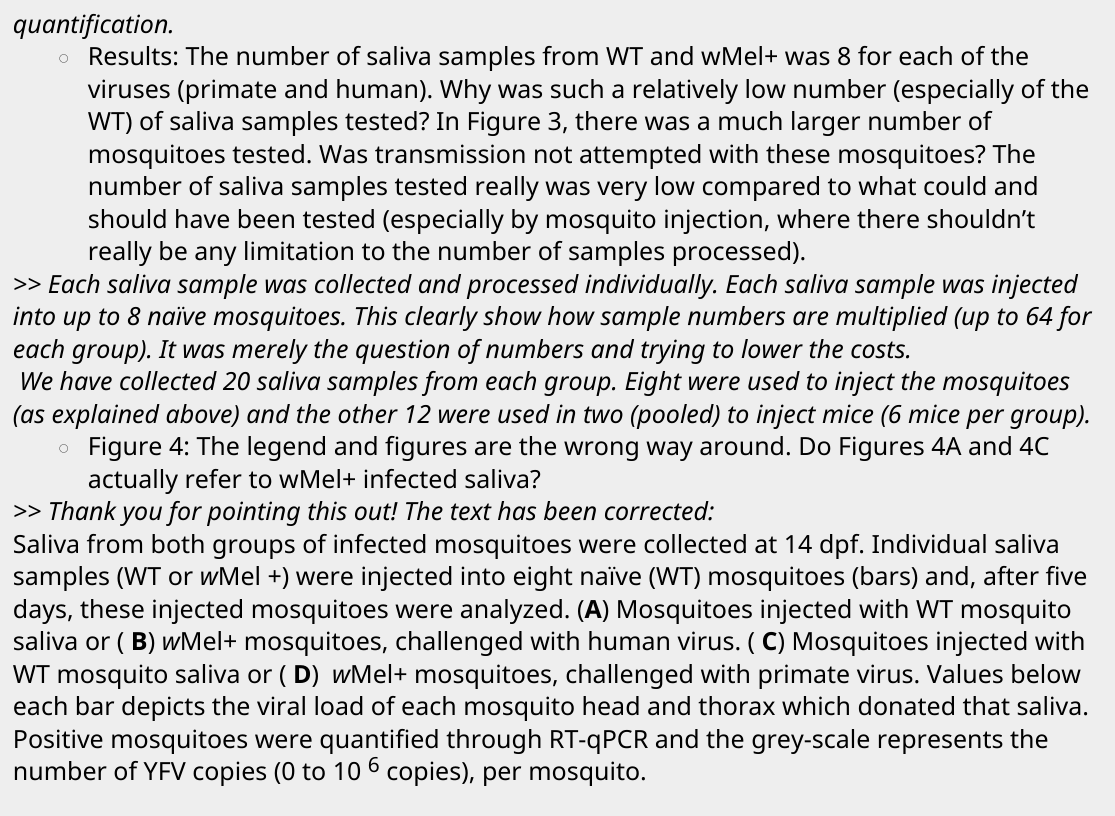
Figure 4: The legend and figures are the wrong way around. Do Figures 4A and 4C actually refer to wMel+ infected